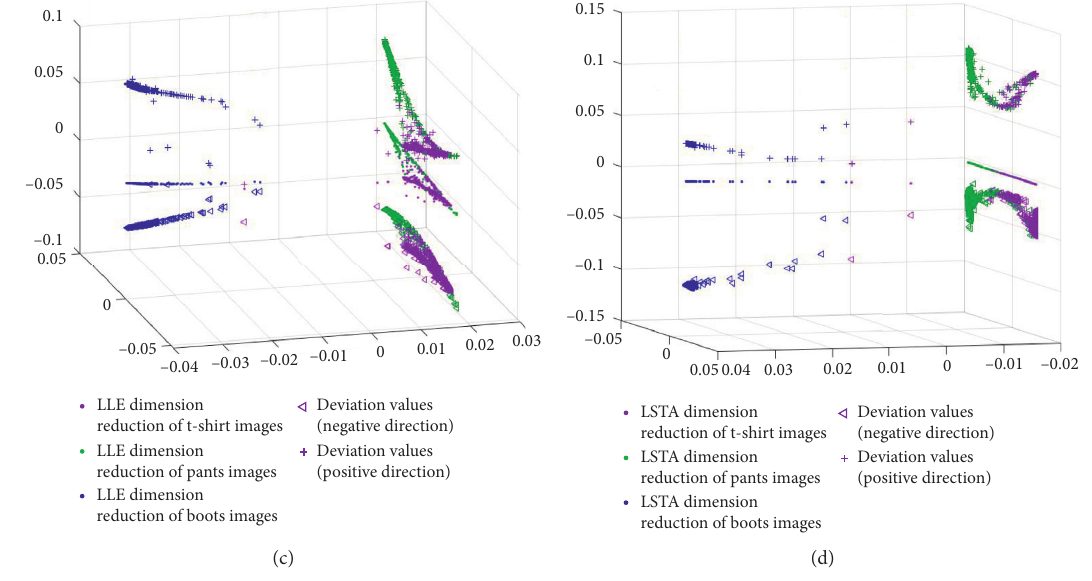
Figure 22: Manifold dimension reduction results of three-class samples and deviation